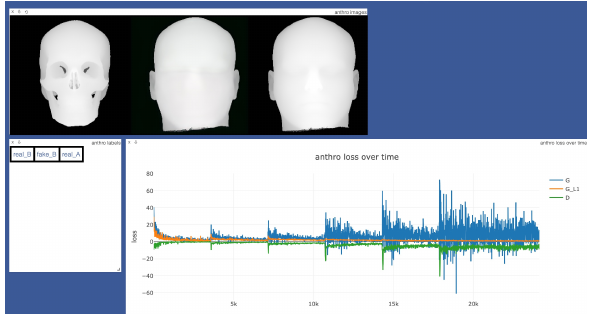
Figure 5. Staged training